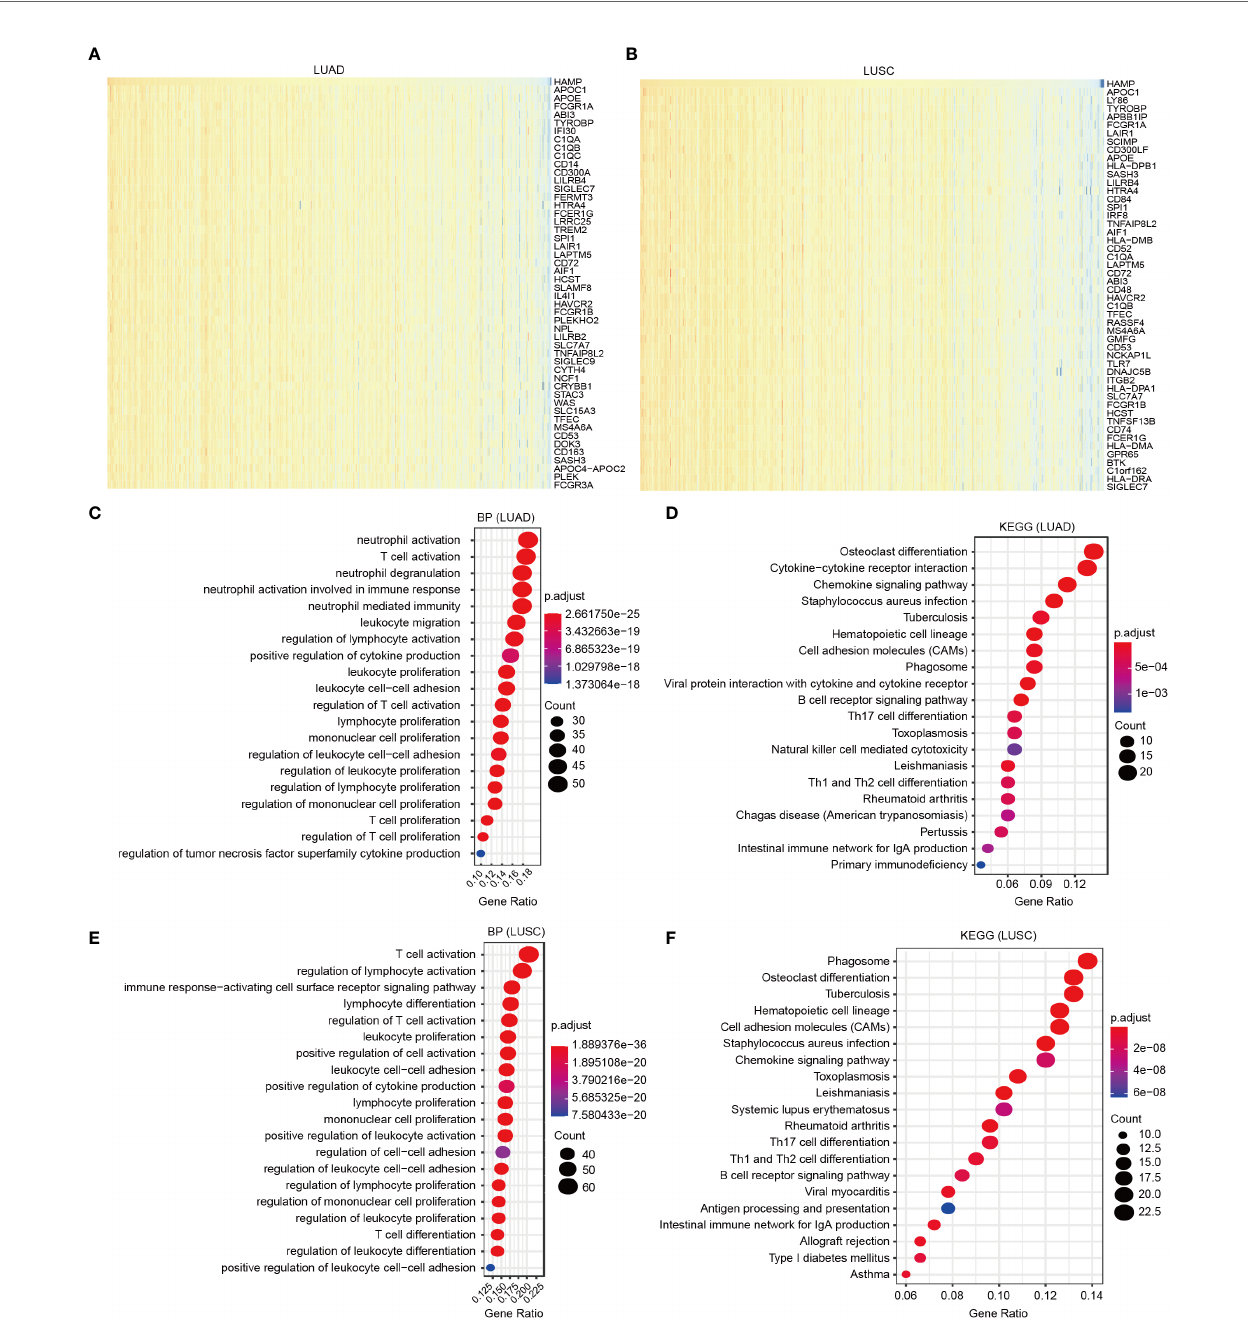
FIGURE 6 | GO and KEGG enrichment analysis for hepcidin. (A) Heat maps showing the top 50 genes positively correlated with hepcidin in LUAD. (B) Heat maps showing the top 50 genes positively correlated with hepcidin in LUSC. (C) Top 20 enrichment terms in BP categories in LUAD. (D) Top 20 enrichment terms in BP categories in LUSC. (E) Top 20 KEGG enrichment pathways in LUAD. (F) Top 20 KEGG enrichment pathways in